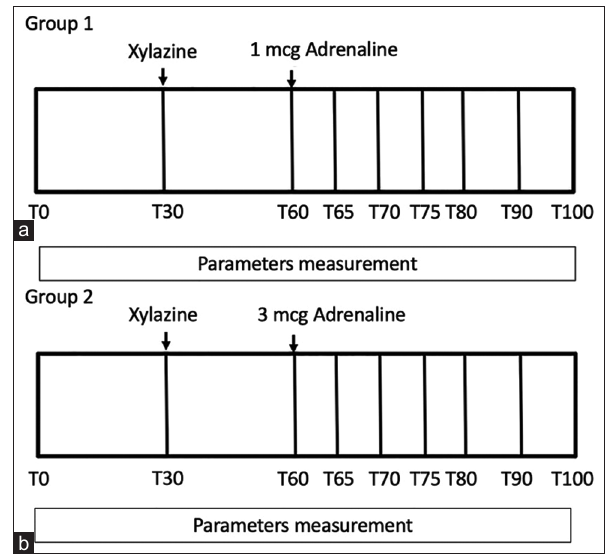
Figure-1: (a and b) In the study protocol, all parameters were evaluated before administering xylazine (T0) and immediately after xylazine administration (T30), immediately after adrenaline administration (T60), and at 5 and 10 min intervals until 100